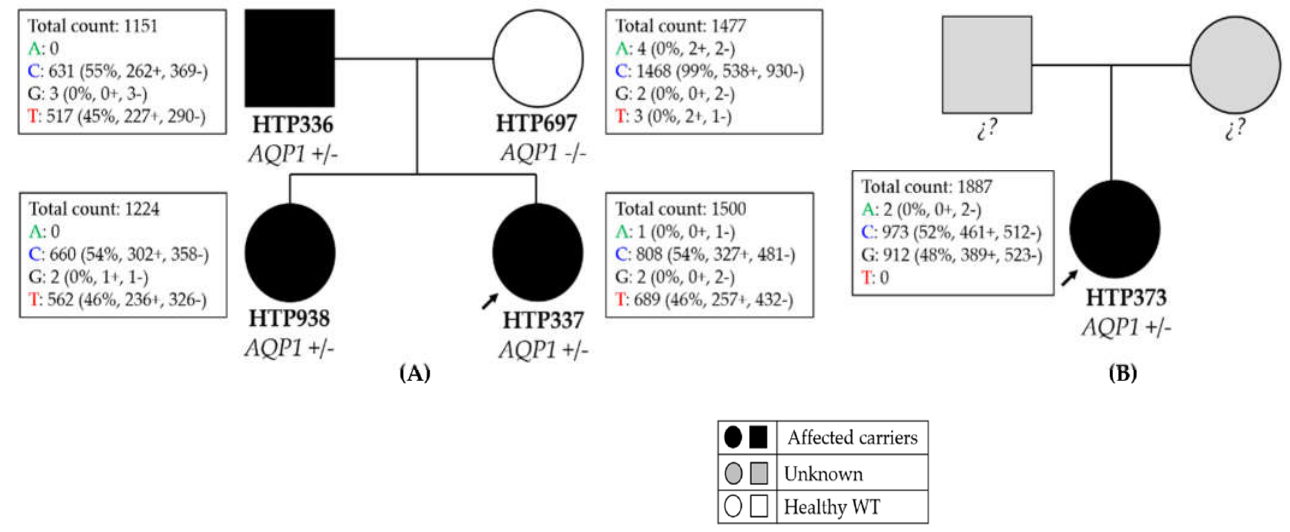
Figure 2. Pedigree of the families with AQP1 variants. ( A ) Pedigree of Family 1. The heterozygous missense variant at nucleotide position c.376 (c.376C > T) in AQP1 (NM_198098.3) causes an amino acid substitution of an arginine to cysteine at position 126 (p. Arg126Cys). The same heterozygous missense variant was found in her affected father and sister. ( B ) Pedigree of Family 2. The heterozygous missense variant at nucleotide position c.423 (c.423C > G) in AQP1 (NM_198098.3) causes an amino acid substitution from isoleucine to methionine at position 141 (p. Ile141Met) of the protein. Samples of these parents were not available. Legend: +/+ homozygous for the alternative allele; +/− heterozygous. Boxes indicate the information of the reads obtained in the WES. Legend: + forward reads; − reverse reads.